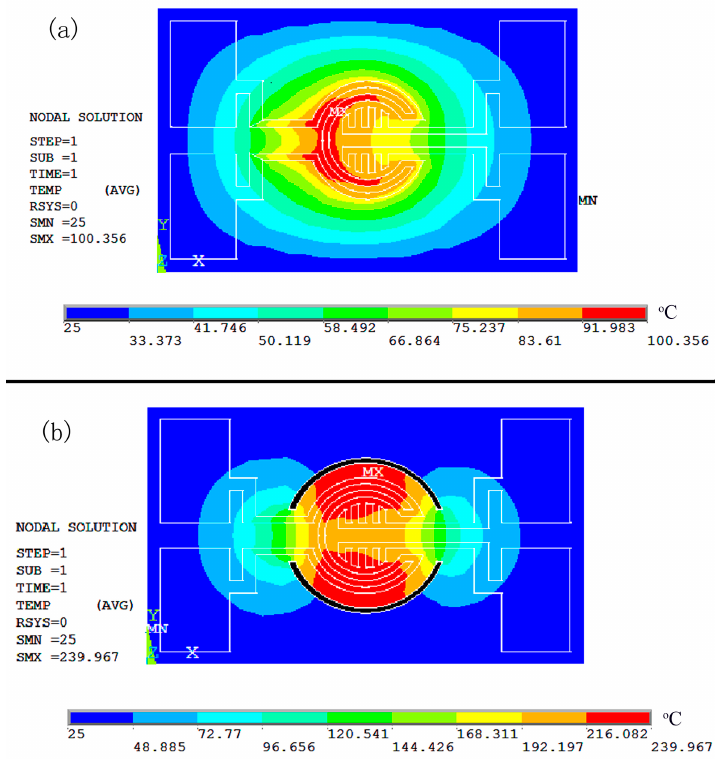
Figure 3. Temperature field distribution maps of finite element simulation of the thermal structure for the micro hotplate sensor ( a ) before thermal isolation and ( b ) after thermal isolation.